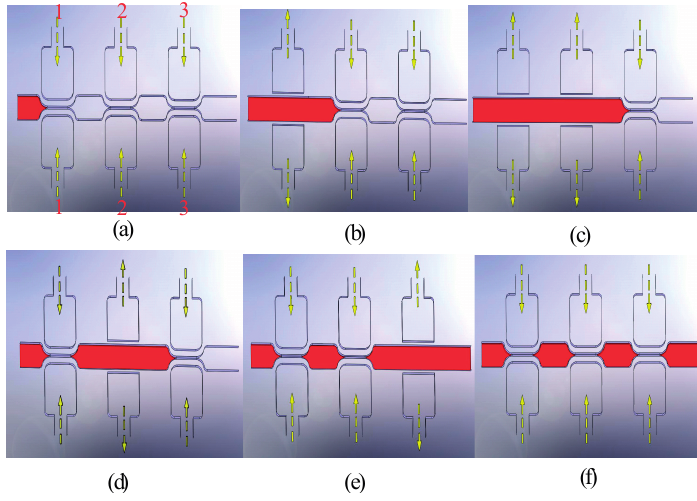
Figure 2. Schematic representations of a pumping process in a three-pair double-side mode micropump. Here, arrow direction indicates the air input/output. 1, 2, and 3 indicate the pair number. ( a ) 3 pairs simultaneously shut down to block the fluid. ( b ) 1st pair and ( c ) 2nd pair sequentially open to induce the fluid to move. ( d ) 1st pair and ( e ) 2nd pair sequentially shut down and 3rd pair open to enhance the fluid forward. ( f ) 3 pairs simultaneously shut down again to avoid the backflow.